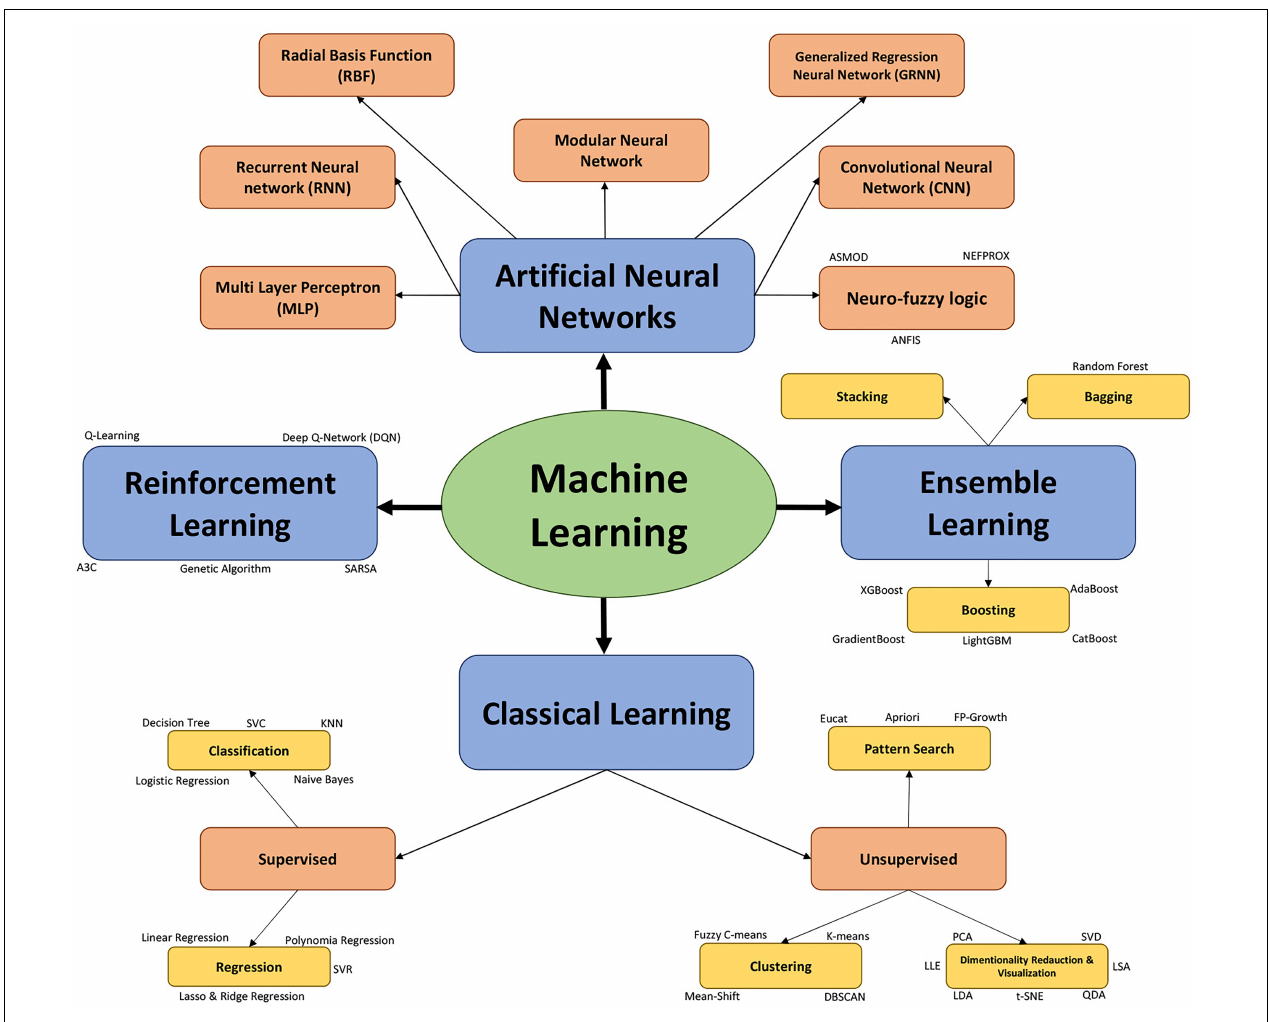
FIGURE 2 | A schematic representation of different classes of machine learning